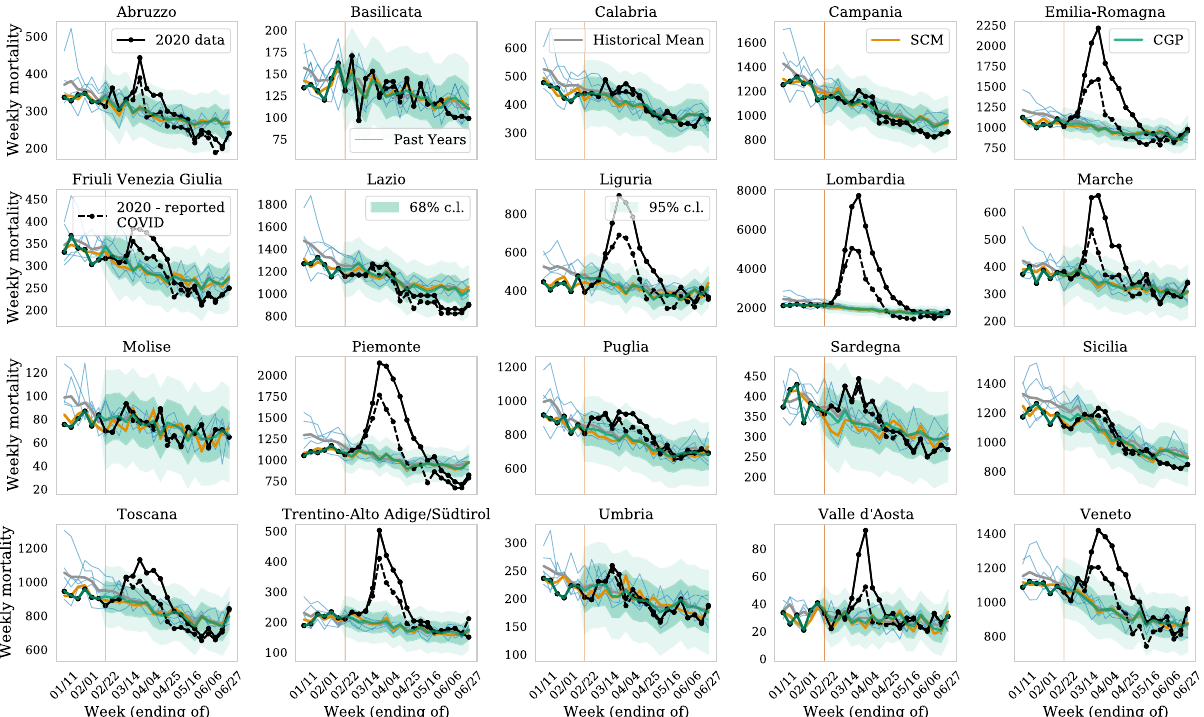
Fig. 1 Validating counterfactuals for the pre-pandemic data. we show the observed weekly mortality due to all causes for the period of 1 January to June 27 (black) in all 20 regions in Italy, and our prediction for the expected mortality in the absence of COVID-19 (conditional Gaussian Process (CGP) with its 1 and 2 − σ error from the variance of the Gaussian model, i.e., 68% and 95% con fi dence interval, respectively, in green and synthetic controls method (SCM) in orange). The fi rst reported COVID-19 mortality occurred in the week ending on February 22 (thin red vertical line). The historical data from 2015 to 2019 (blue) and corresponding historical mean (gray) is shown for comparison and are not a good fi t to the observed pre-pandemic data. In the dashed- black line, we also show the observed mortality after removing reported COVID-19